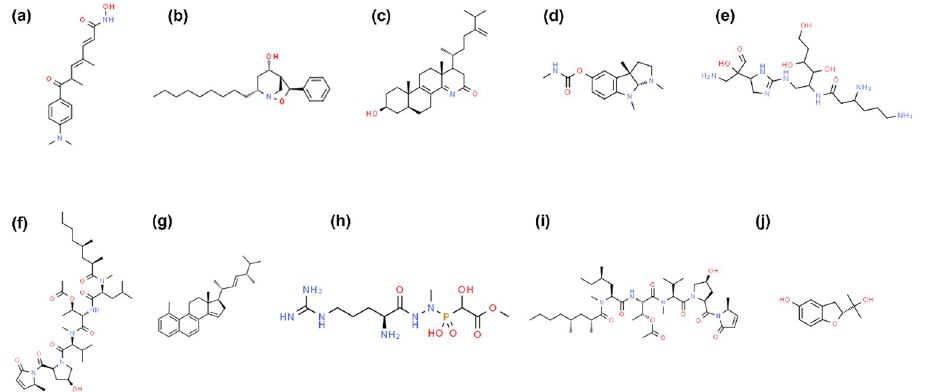
Fig 3. 2D representation of the top 10 compounds screened using NET5 model based on the predicted pIC 50 . (a) CMP1 (NET5) (b) CMP2 (NET5) (c) CMP3 (NET5) (d) CMP4 (NET5) (e) CMP5 (NET5) (f) CMP6 (NET5) (g) CMP7 (NET5) (h) CMP8 (NET5) (i) CMP10 (NET5) (j) CMP4 (NET5)